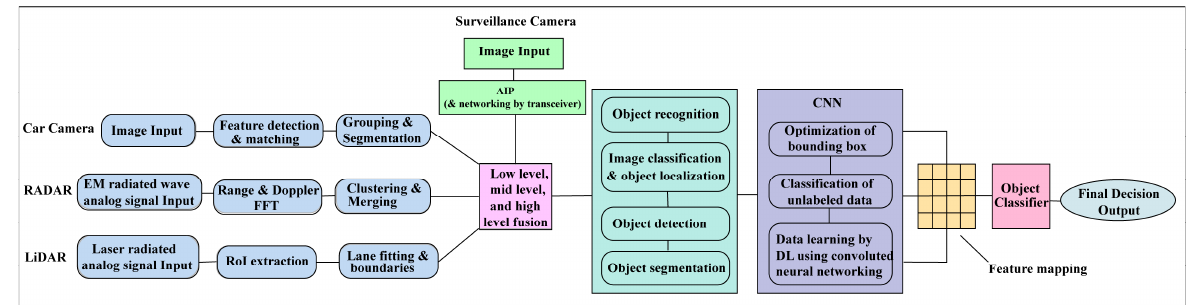
Figure 11. Convolutional neural networking model for DL and AI processing.